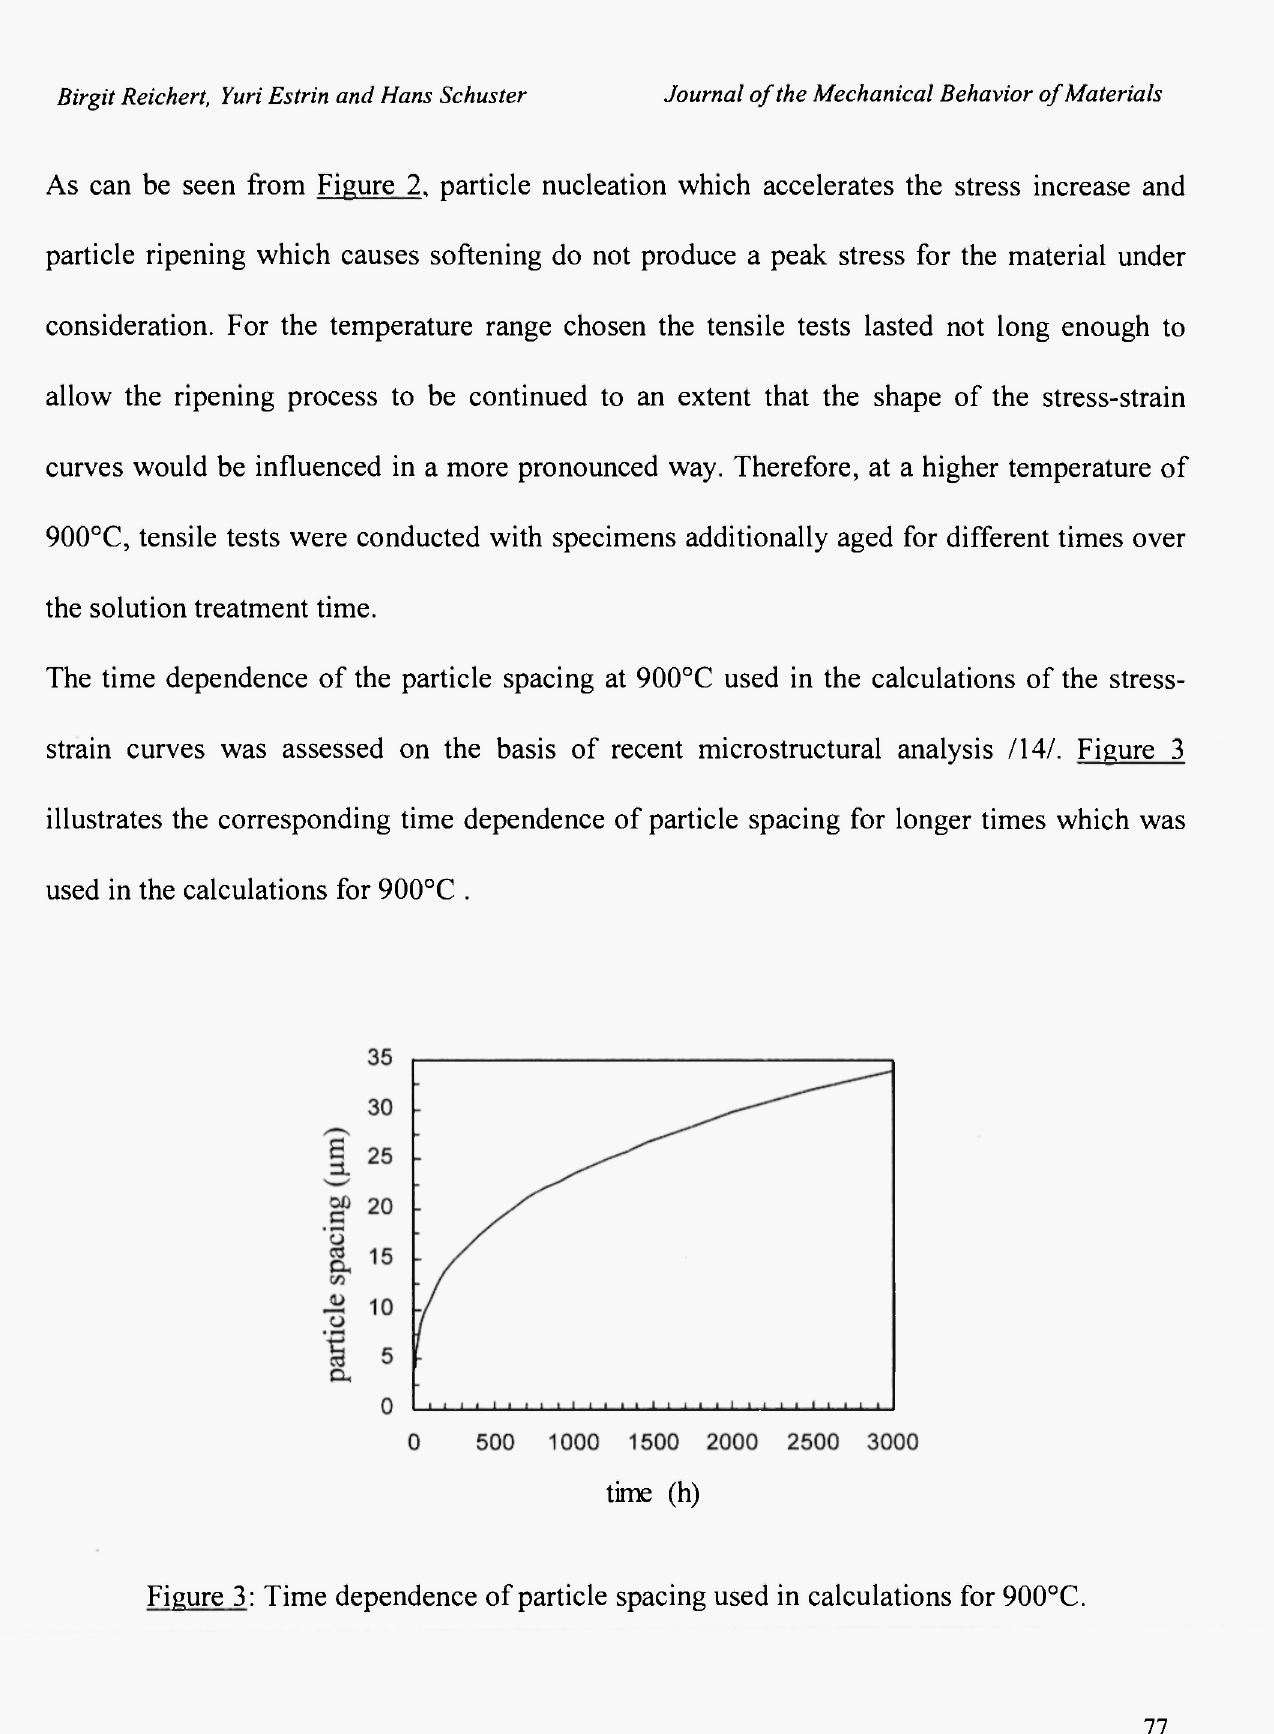
Figure 3: Time dependence of particle spacing used in calculations for